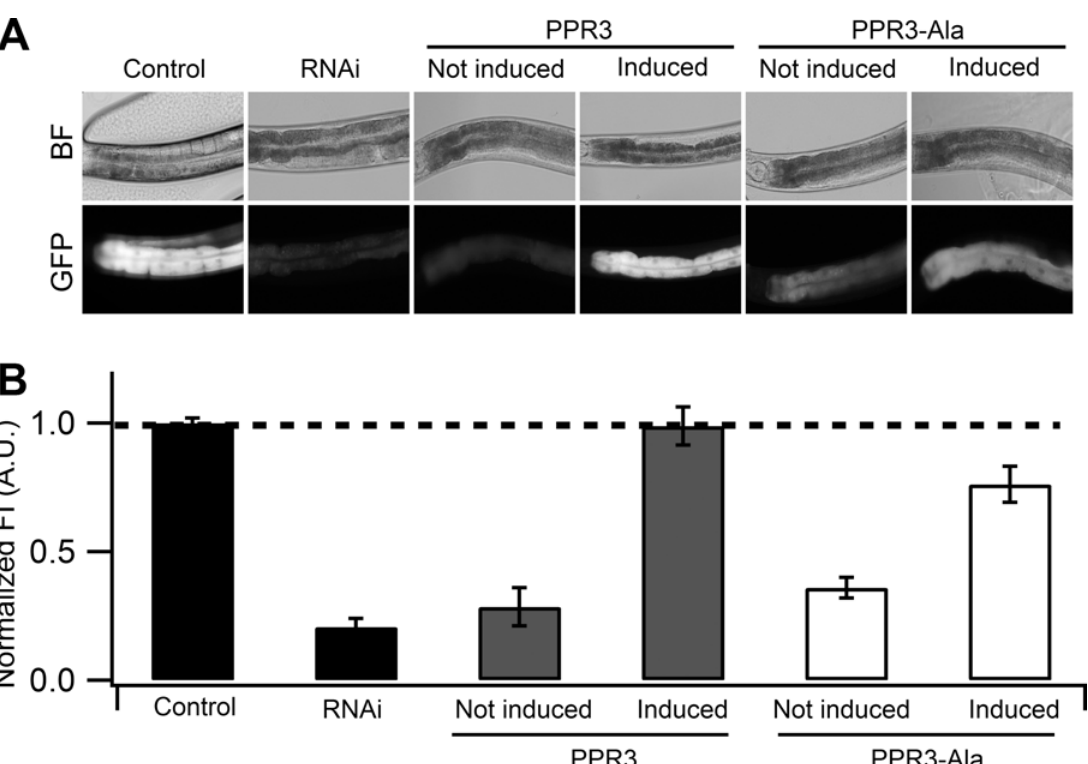
Fig 4. Suppression of RNAi in C . elegans by PPR3 and PPR3-Ala. The gfp -transgenic strain RT476 was transformed to express PPR3 or PPR3-Ala under a heat shock — inducible promoter. Sense-mediated silencing of gfp expression was induced in the nematodes by feeding them E . coli expressing gfp mRNA (RNAi). In Control, gfp -transgenic nematodes were fed bacteria harboring an insert-less plasmid. After 24 h, expression of PPR3 and PPR3-Ala was induced by heat shock in the gfp -silenced nematodes, which recovered GFP fluorescence by 72 h post-induction. ( A ) gfp -transgenic C . elegans (strain RT476) in bright field (BF) to observe morphology or under UV illumination to observe GFP fluorescence. The anterior intestine and posterior intestine are oriented to the left and right, respectively (see also Fig. 3B). ( B ) Normalized average GFP fluorescence intensity (FI) shown using arbitrary units (A.U.) in four independent experiments. Two transgenic lines expressing each protein were included in the experiments. Error bars indicate S.E. (n = 38 – 50). GFP fluorescence intensity is significantly higher in the nematodes induced to express PPR3 than PPR3-Ala, but in both it is higher than in uninduced controls (Student ’ s t-test, p < 0.001). Dashed line indicates the level of GFP fluorescence in control.